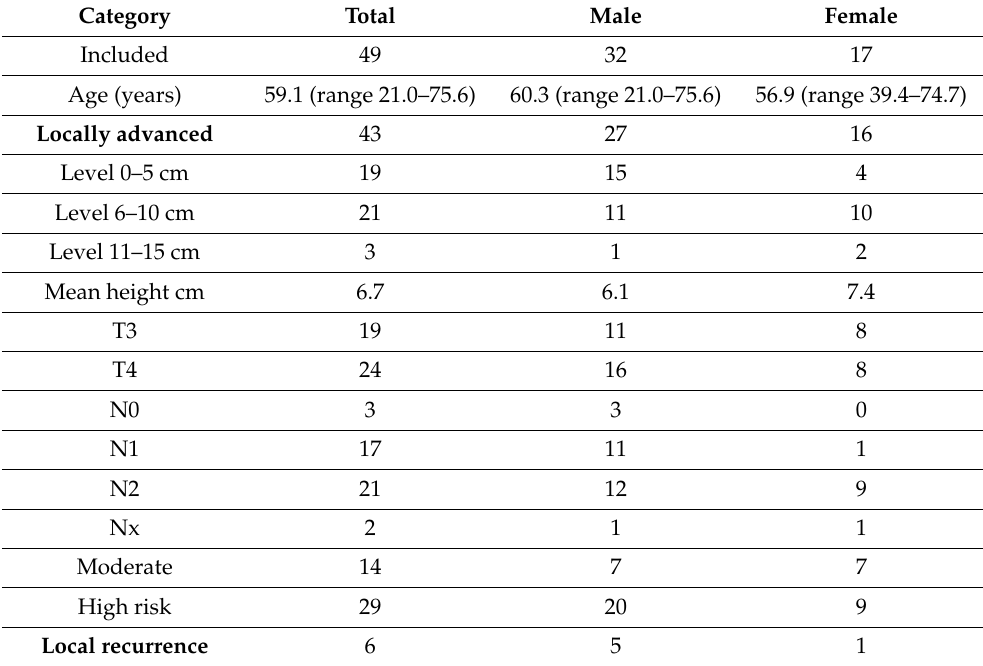
Table 1. Patient characteristics for patients included and treated according to the study